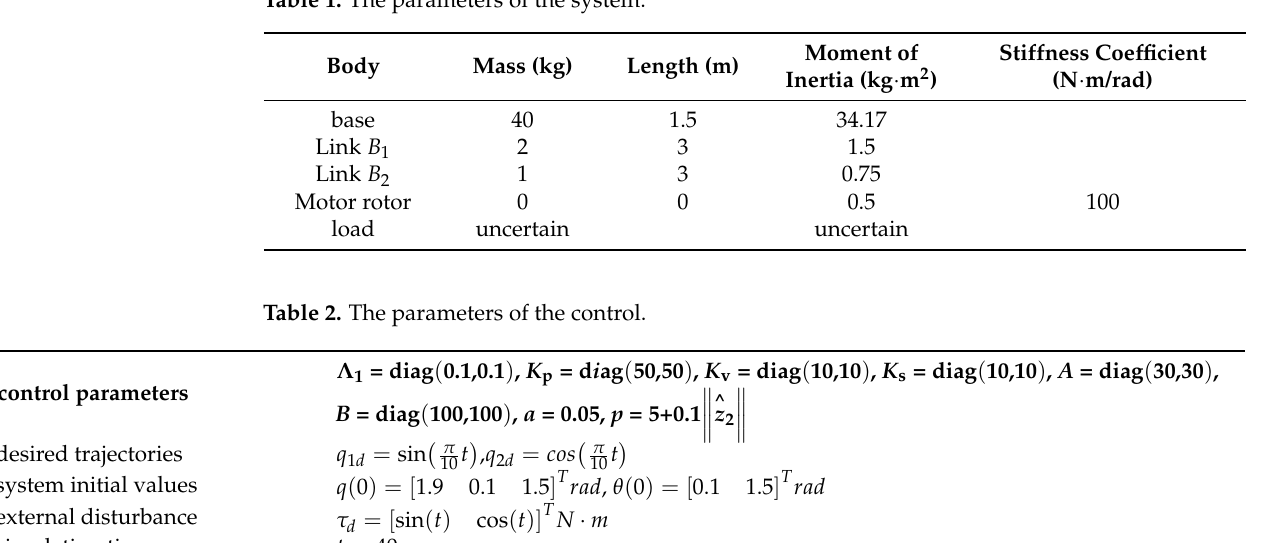
Table 1. The parameters of the system.